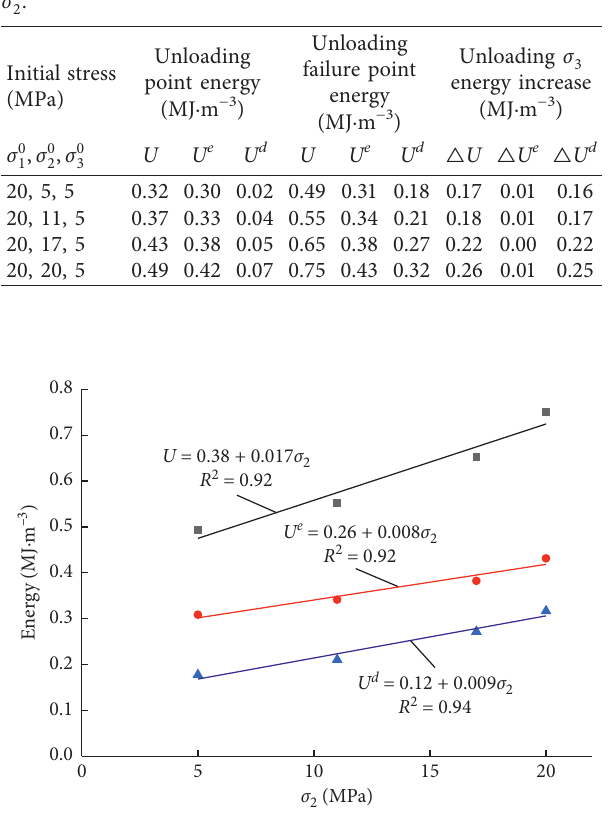
at the failure point under 2